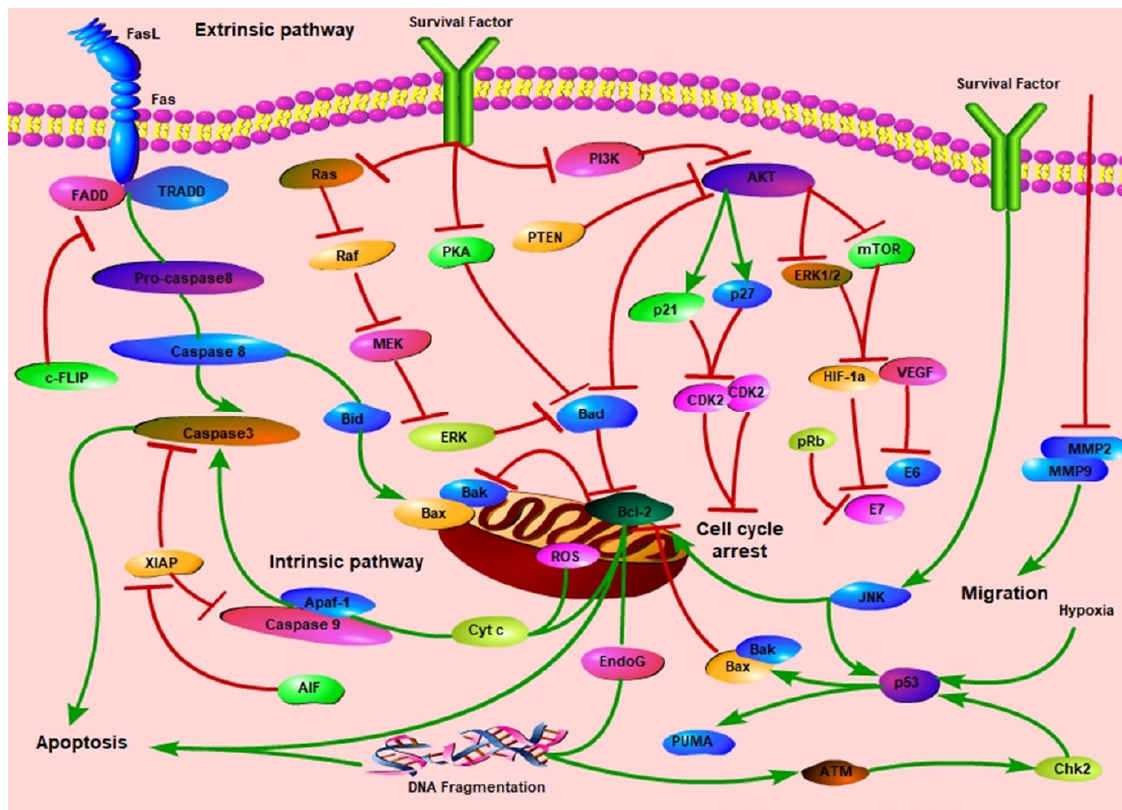
Figure 6. Overview of signaling pathways against cervical cancer.